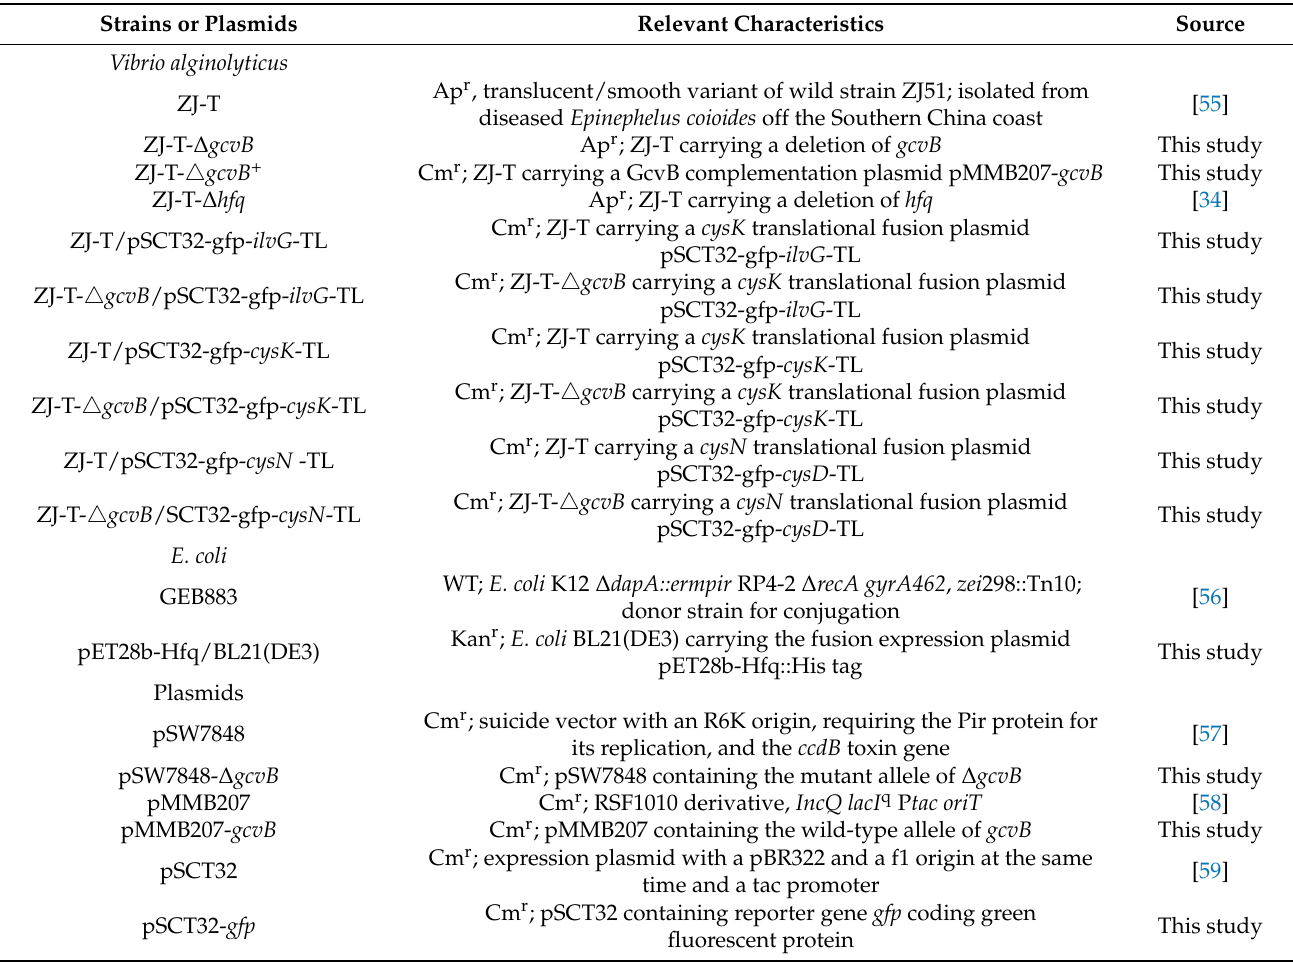
Table 1. Strains and plasmids used in this